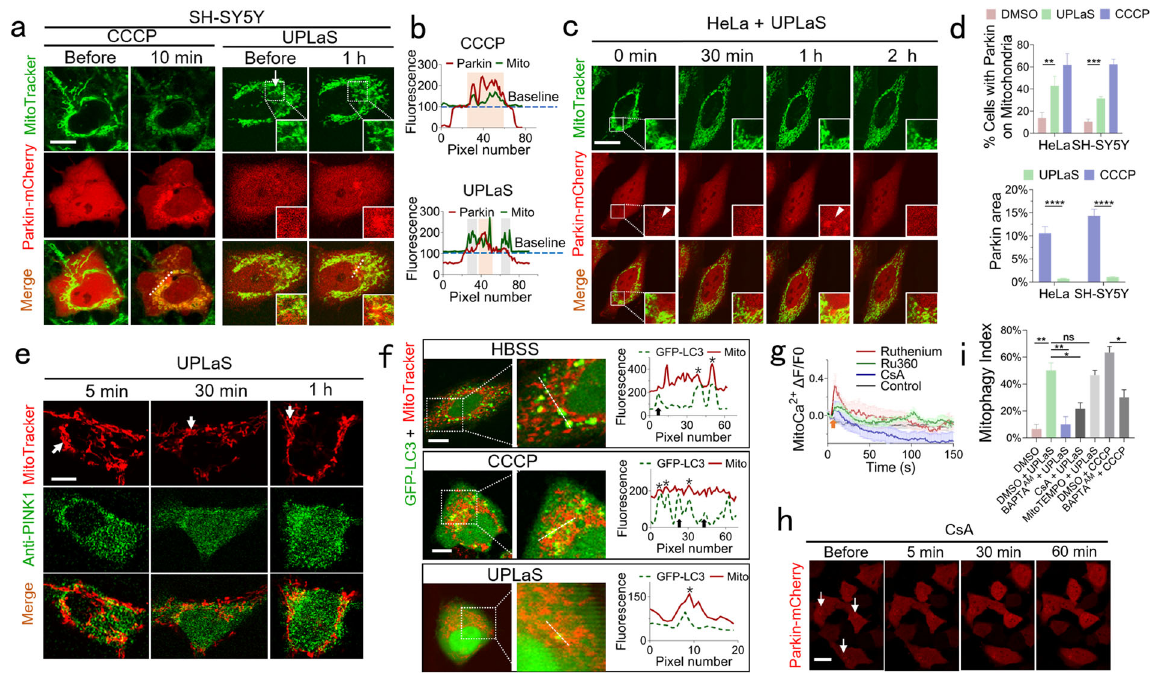
Fig. 2 Parkin recruitment and PINK1 accumulation by UPLaS. a SH-SY5Y cells transfected with Parkin-mCherry (red) and stained with MitoTracker Green (green). Arrow: the UPLaS location. Inserts: Parkin recruitment to mitochondria with UPLaS. b The fl uorescence intensity plot along a randomly selected line in cells in a . c The time-lapse dynamics of Parkin-mCherry after UPLaS. d The cell ratio of Parkin recruitment in HeLa ( n = 20) and SH-SY5Y ( n = 35) cells, respectively up and the Parkin recruitment area ratio over the whole cells down. e The PINK1 localization after UPLaS. f . The colocalization of mitochondria (MitoTracker Red) and autophagosomes (GFP-LC3) 1.5 h after UPLaS. Note in the HBSS and CCCP groups, the LC3 puncta coincided with mitochondria (stars) or misaligned with mitochondria (arrows). g The mitoCa 2 + after UPLaS in the presence of Ru360 (10 μ M, n = 20), ruthenium (10 μ M, n = 20), and CsA (10 μ M, n = 20), respectively. h The Parkin-mCherry dynamics in cells treated with CsA after UPLaS ( n = 25). i The mitophagy index in cells treated with UPLaS in the presence of CsA, BAPTA-AM, and MitoTEMPO, respectively, or treated with CCCP in the presence of BAPTA-AM ( n = 30 in each group). Bar: 20 μ m. * p < 0.05, ** p < 0.01, *** p < 0.001, **** p <